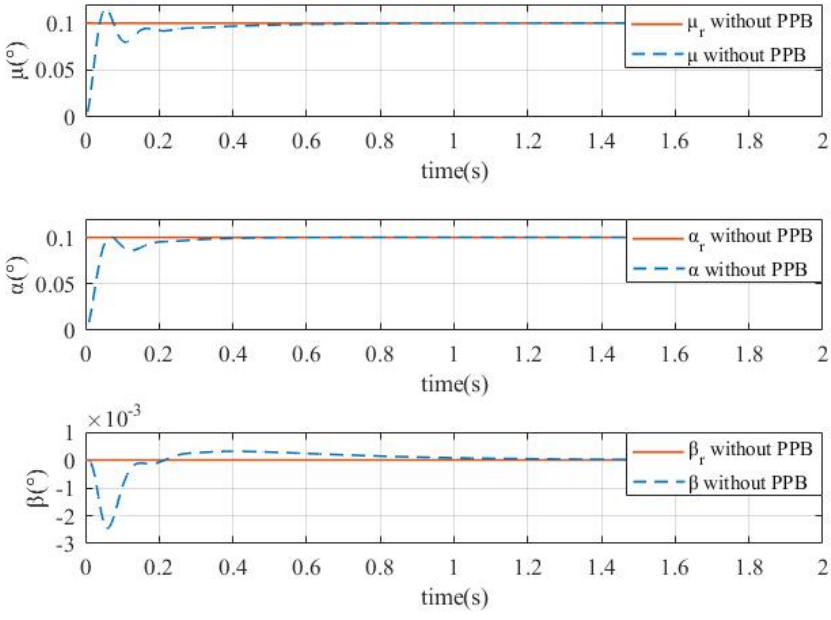
Figure 15. Tracking response of µ , α and β without PPB.